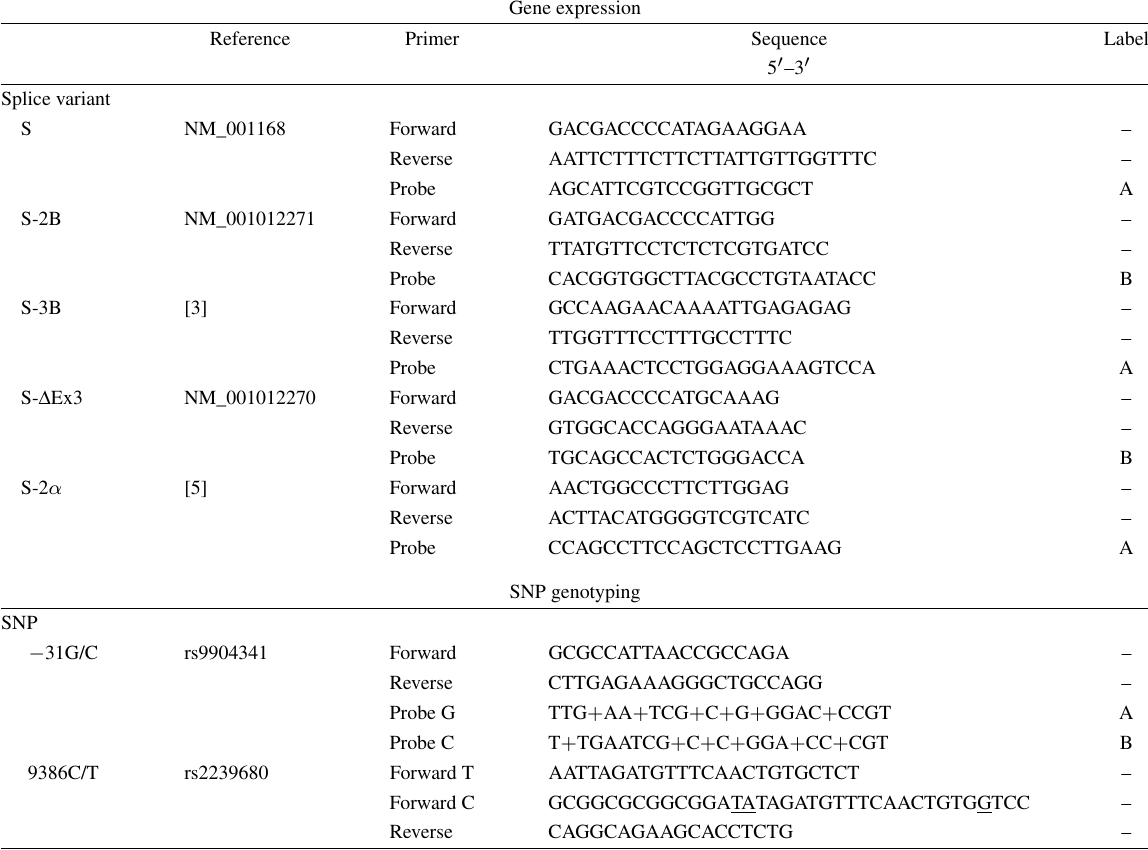
Sequences of primers and